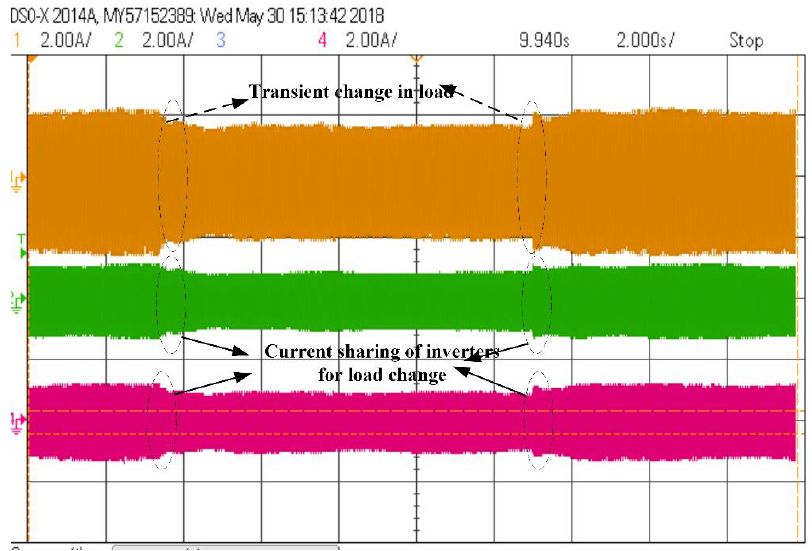
Figure 23. Load variation during parallel operation.